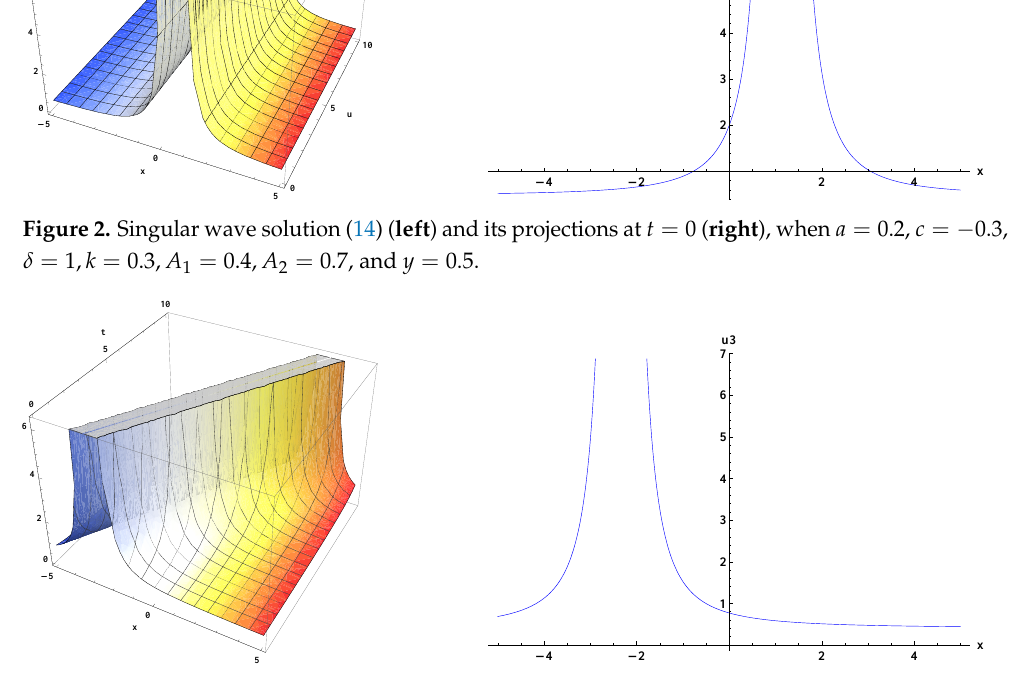
Figure 3. Singular wave solution (15) ( left ) and its projections at t = 0 ( right ), when a = 0, c = 0.4, δ = 1, k = 0.6, A 1 = 0.3, A 2 = 0.7, and y =